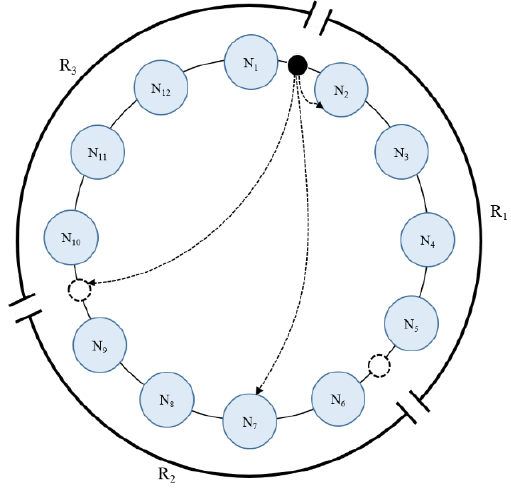
Figure 8. Hot data replication.